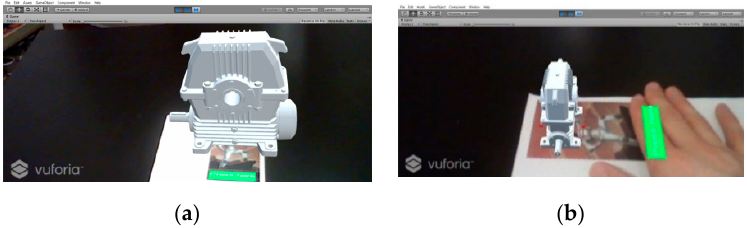
Figure 34. ( a ) Virtual Button in AR (1:4 scale reducer); ( b ) VirtualButton in AR (1:10 scale reducer).